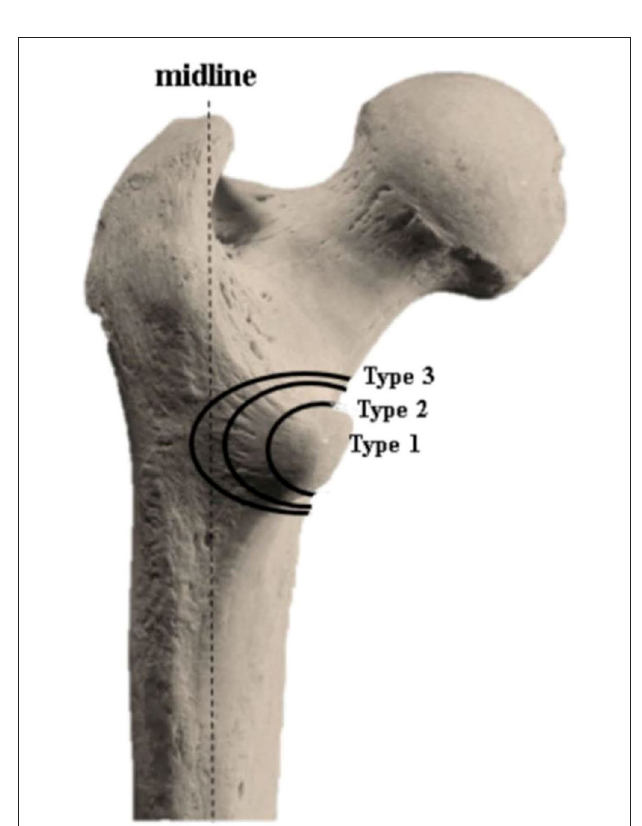
FIGURE 2 | Classification for medial wall